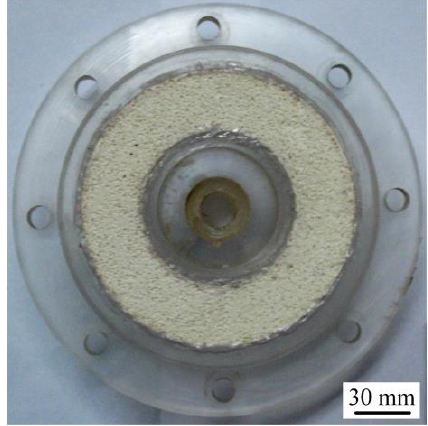
Figure 3. Annular porous plug used in the physical model.